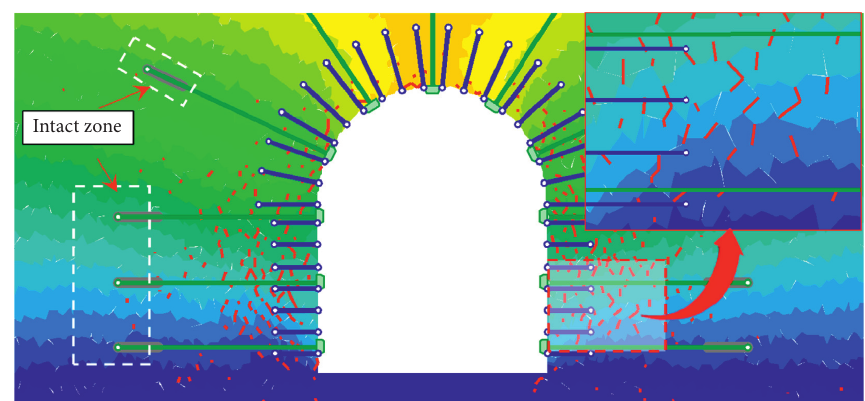
Figure 2: Crack development characteristics of the